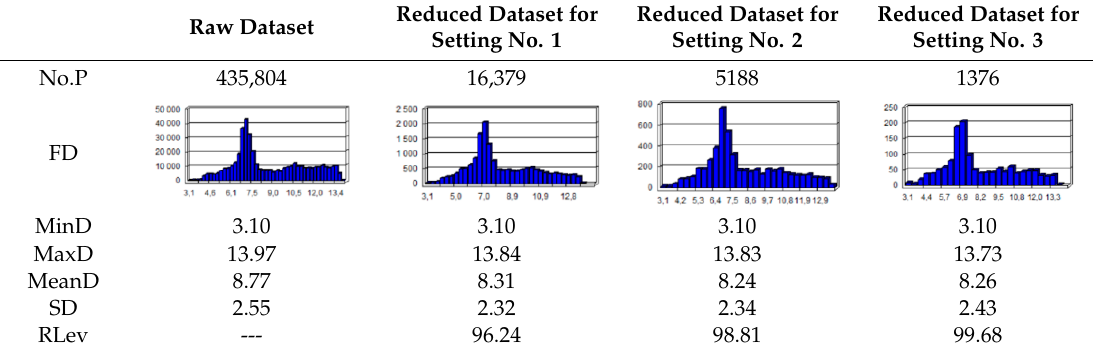
Table 3. Statistics for points reduced with the TBDRed method based on the Inski canal area. Reduced Dataset for Raw Dataset Setting No. 1 Setting No. 2 Setting No. 3